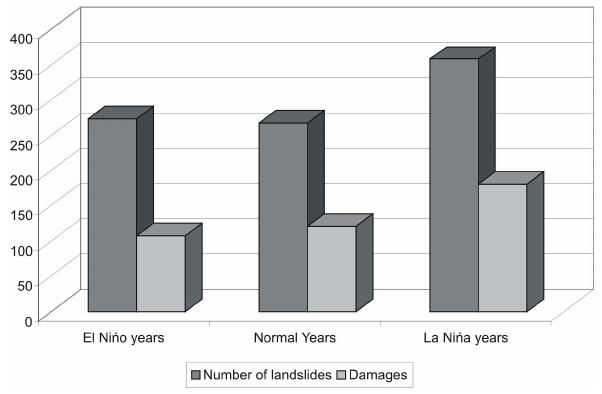
Fig. 7. The annual distribution of landslides and landslide damage (affected and destroyed houses) summarized for El Ni˜no, “normal”, and La Ni˜na